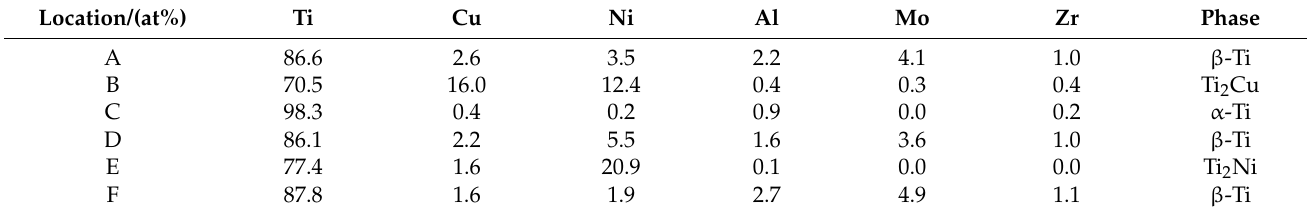
Figure 3. SEM-BEI photos and EBSD maps of Ti-1553/Ti–Cu–Ni/CP-Ti joint brazed at 1243 K for 3 min: ( a ) cross section overview; ( b – d ) higher magnification of location I, II, III in 3a; ( e – g ) EBSD phase maps of 3b to 3d. Table 2. Chemical compositions of positions A–F in Figures 3b–d and